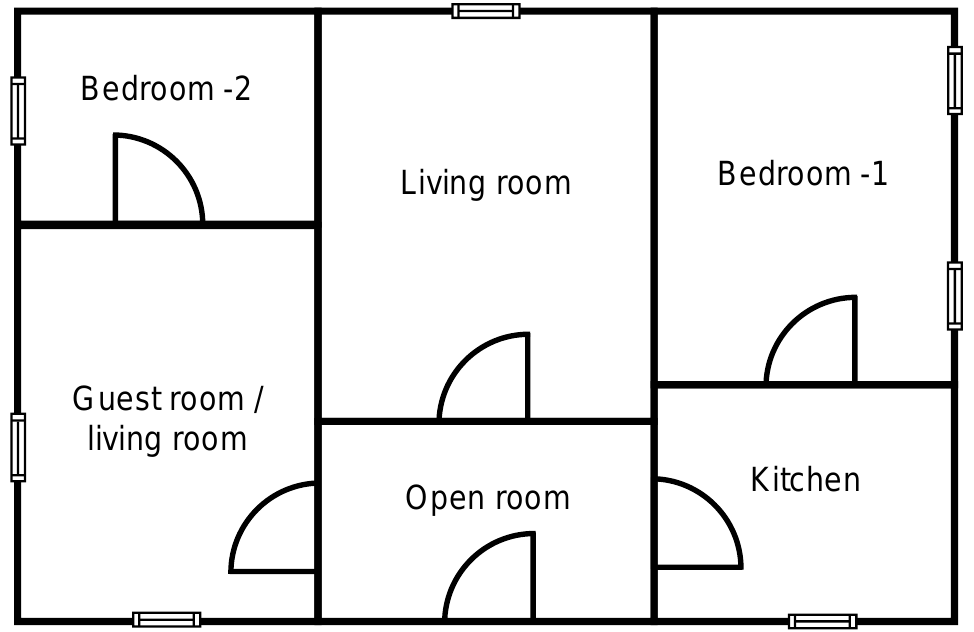
Figure 6. Typical architectural plan of rural Kyrgyz house (own illustration based on the site visit). Especially in high-altitude mountain areas, rural settlements have low population density; therefore, most rural houses in Kyrgyzstan are detached. Outside the house, householders tend to build small storage areas and a yard to accommodate livestock. However, this storage and the open yard are not a part of the building construction and they tend to be arranged according to the available number of livestock and farming capacity. Also, most rural homes have a separate structure (room) for summer cooking.